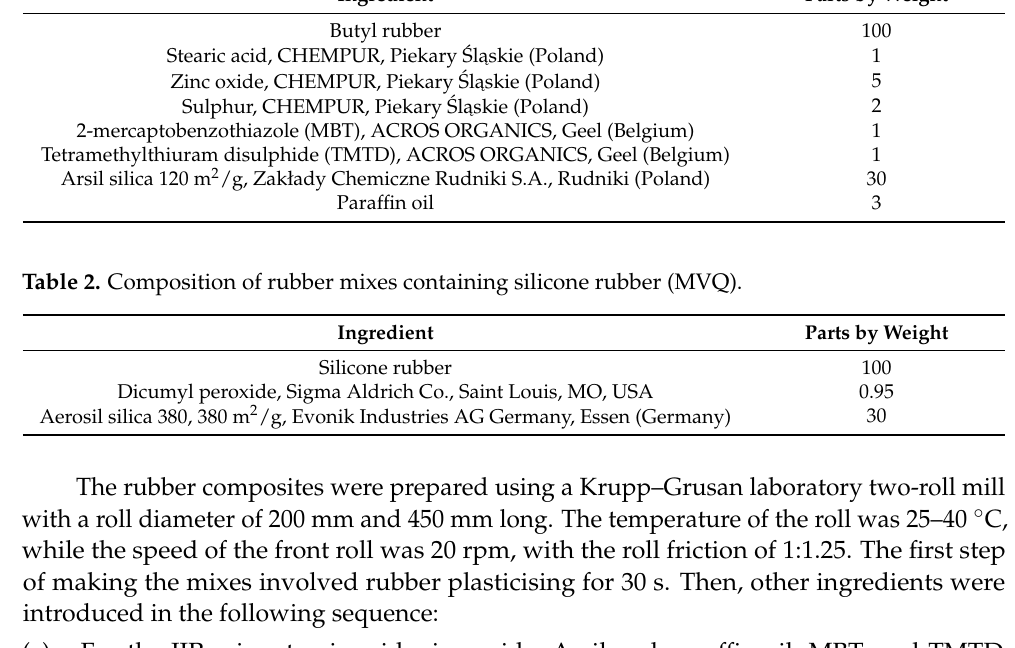
Table 1. Composition of rubber mixes containing butyl rubber (IIR). Ingredient